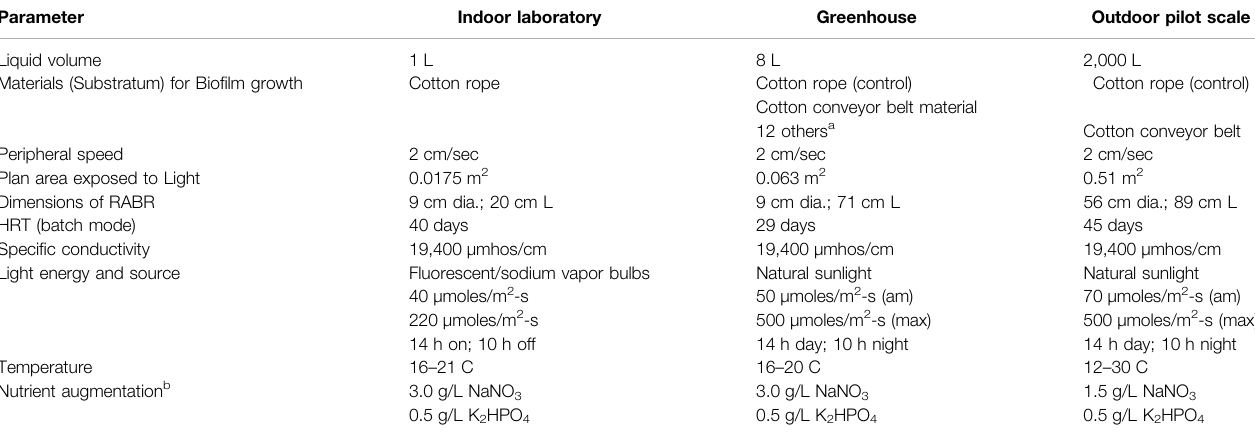
TABLE 1 | Rotating algae bio fi lm reactors for biomass and phycocyanin production from produced water-based media.